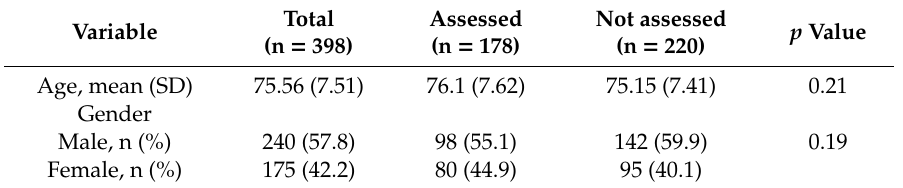
Table A1. Age and gender of individuals aged ≥ 65years admitted to acute medical